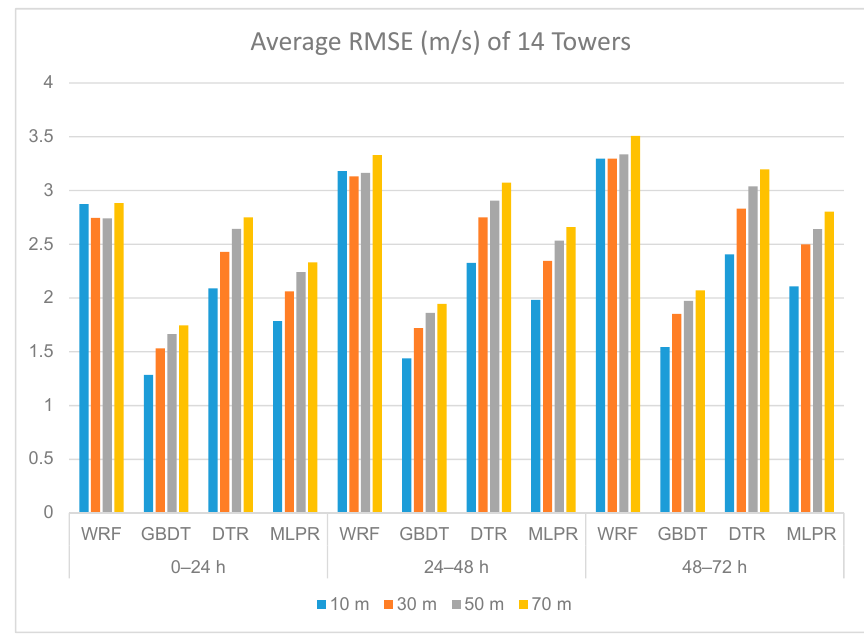
Figure 7. RMSEs of the WRF original output (WRF), GBDT output (GBDT), decision tree regression output (DTR), and multi-layer perceptron regression output (MLPR).